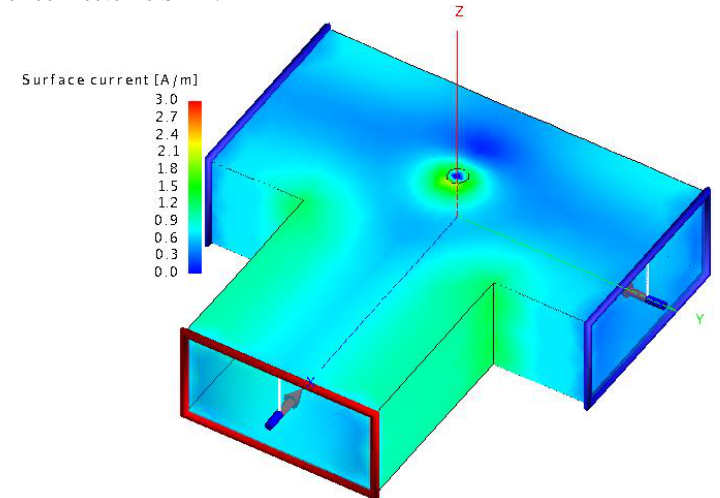
Fig.6. Distribution of current amplitudes for power divider at a frequency of 9 GHz.